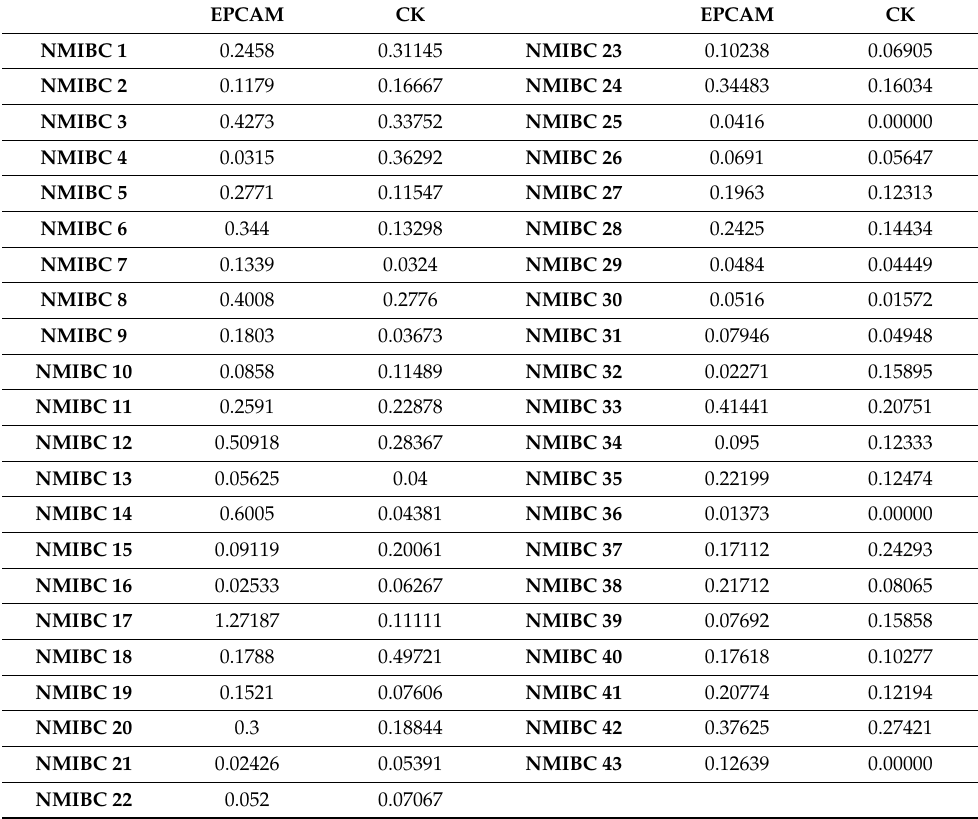
Table 2. Gene expression evaluated by ddPCR. Bold: ID